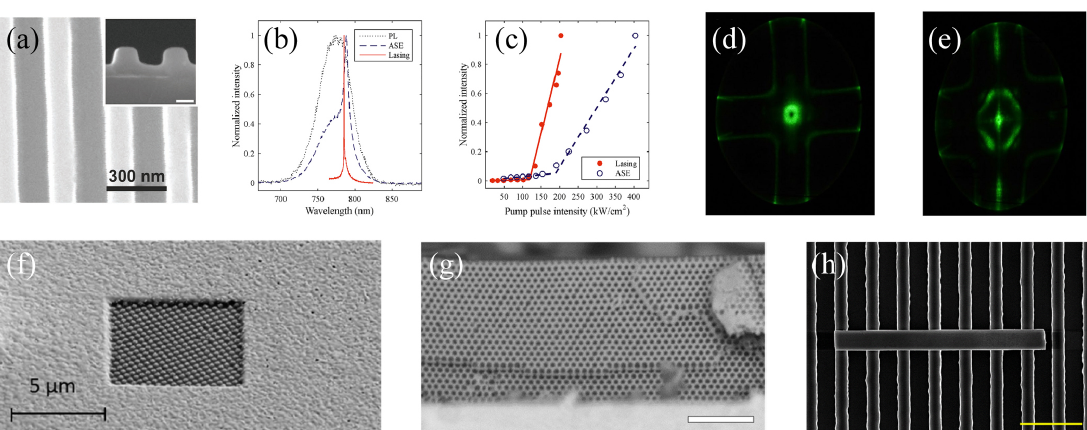
Figure 11. ( a ) SEM images of the DFB grating imprinted into a MAPbBr 3 layer with a periodicity of 300 nm (inset: high resolution cross-section, scale bar is 100 nm). Adapted with permission from [66]. John Wiley and Sons, 2018. ( b ) PL, ASE, and DFB lasing spectra of MAPbI 3 . ( c ) Emission intensities at the peak wavelengths as a function of the pump pulse intensity of the same MAPbI 3 sample in a position without and with underlying grating, leading to ASE (blue) and lasing (red) at thresholds of 190 µ Jcm − 2 ( ± 38 µ Jcm − 2 ) and 120 µ Jcm − 2 ( ± 24 µ Jcm − 2 ), respectively. ( b , c ) adapted with permission from [67]. AIP publishing, 2016. ( d , e ) Photograph of the output beam of a MAPbBr 3 DFB laser projected on a screen, ( d ) shows the TM mode from a 300 nm grating, while ( e ) shows the TE mode from a 290 nm grating. ( d , e ) adapted with permission from [18]. Springer Nature Publishing, 2017. ( f ) SEM image at a 52 ◦ inclination with respect to the normal of a MAPbI 3 film on top of a 2D grating with a portion of the perovskite removed by focused ion beam to evidence the underlying pattern. Adapted with permission from [68]. OSA Publishing, 2016. ( g ) Cross-sectional SEM of a MAPbBr 3 inverse opal (scale bar 2 µ m). Adapted with permission from [69]. American Chemical Society, 2017. ( h ) Top-view SEM image of a MAPbBr 3 microwire on silicon grating with a periodicity of 5 µ m (scale bar 10 µ m). Adapted with permission from [70]. American Chemical Society,